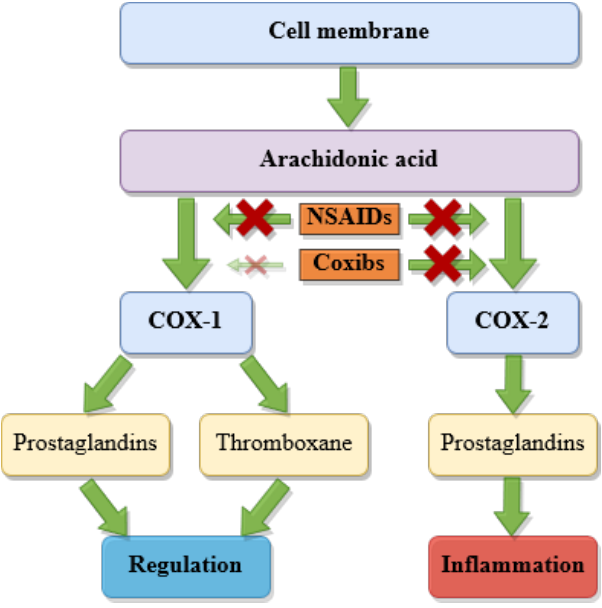
Figure 2: NSAID-mediated COX inhibition COX - Cyclooxygenase Coxib - Selective COX-2 inhibitor NSAIDs - Nonsteroidal anti-inflammatory